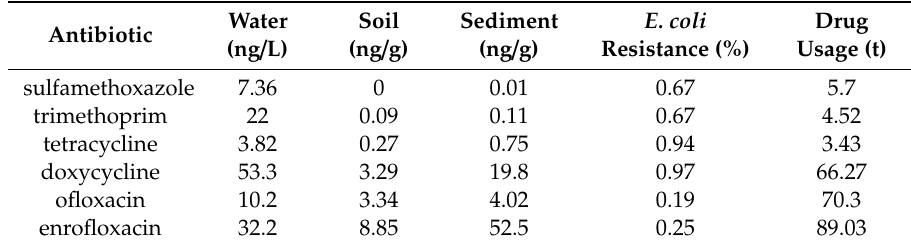
Table 1. Relevant antibiotic data in Chongqing, 2013.